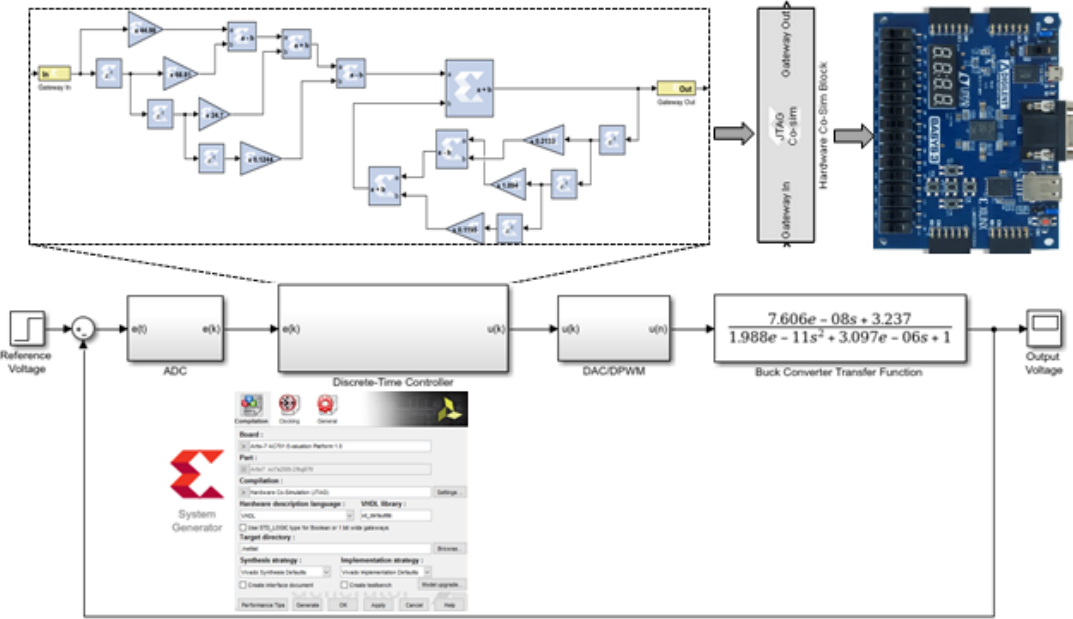
Figure 16. Hardware-in-the-loop (HiL) implementation of the compensated buck converter system.